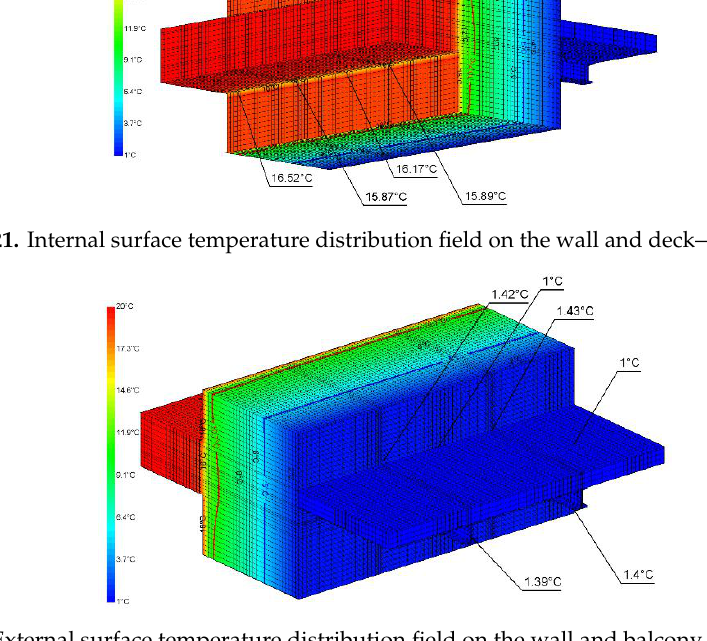
Figure 22. External surface temperature distribution field on the wall and balcony showing both the top and bottom.